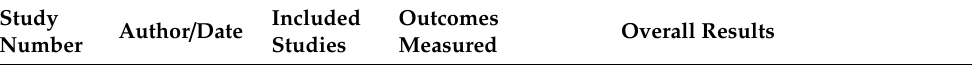
Table 3. E ff ects of other tobacco products